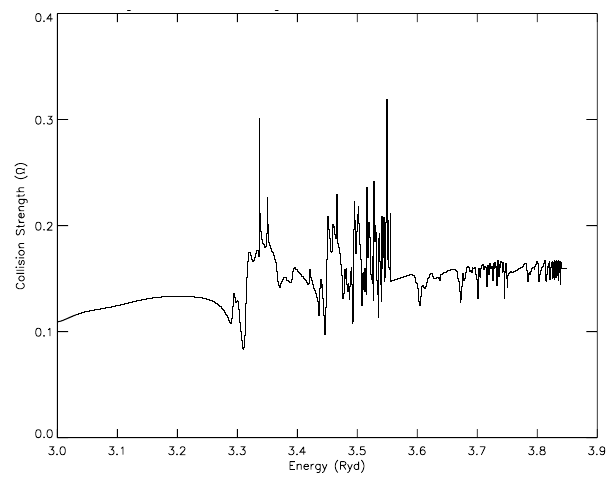
Figure 7. Collision strengths for the 1s 2 S 1/2 –2p 2 P o